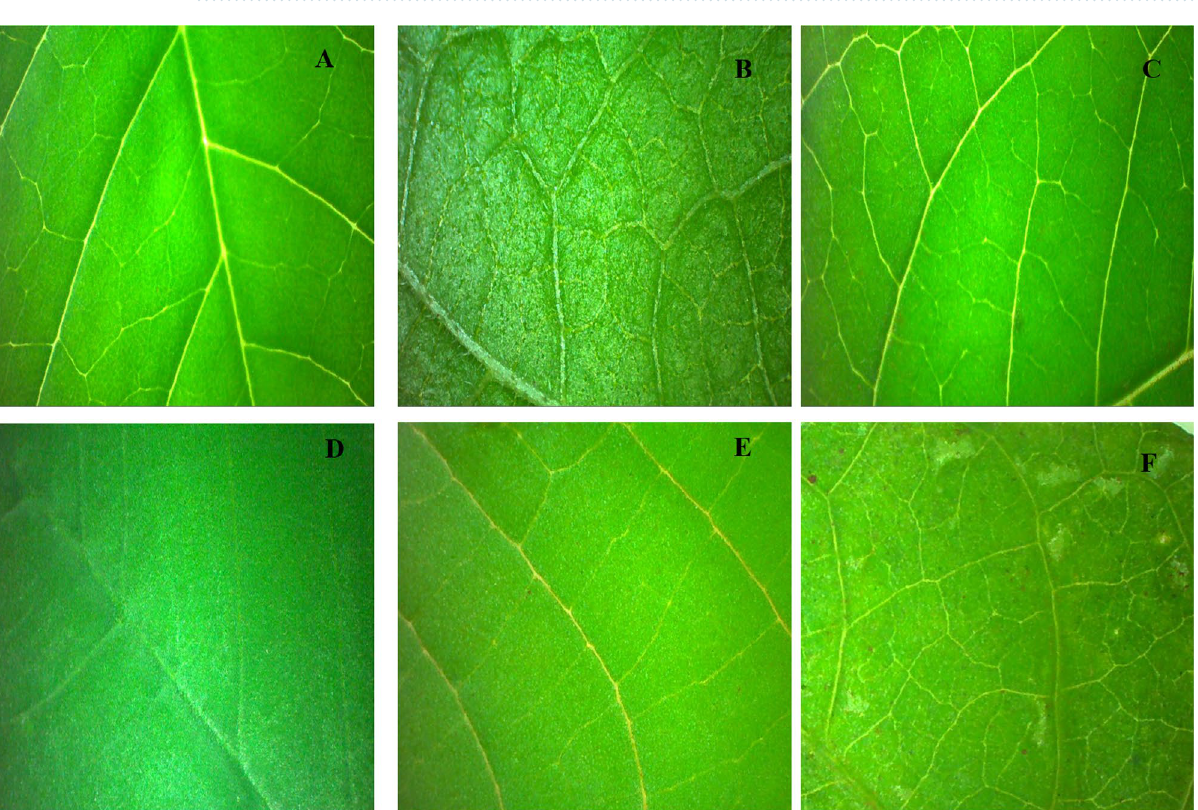
Figure 5. Surface adaxial in plants of the Crotalaria incana L. ( A ), Lantana camara L. ( B ), Asclepias curassavica L. ( C ), Senna obtusifolia (L.) H.S.Irwin & Barneby ( D ), Ricinus communis L. ( E ) and Ipomoea grandifolia (Dammer) O’Donell ( F ) taken on the Stereoscopic Microscope with ×